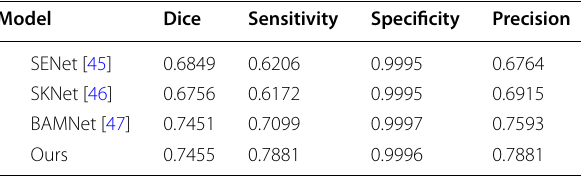
Table 5 Comparison of the performances of some state-of-the- art models on the ADAM test set